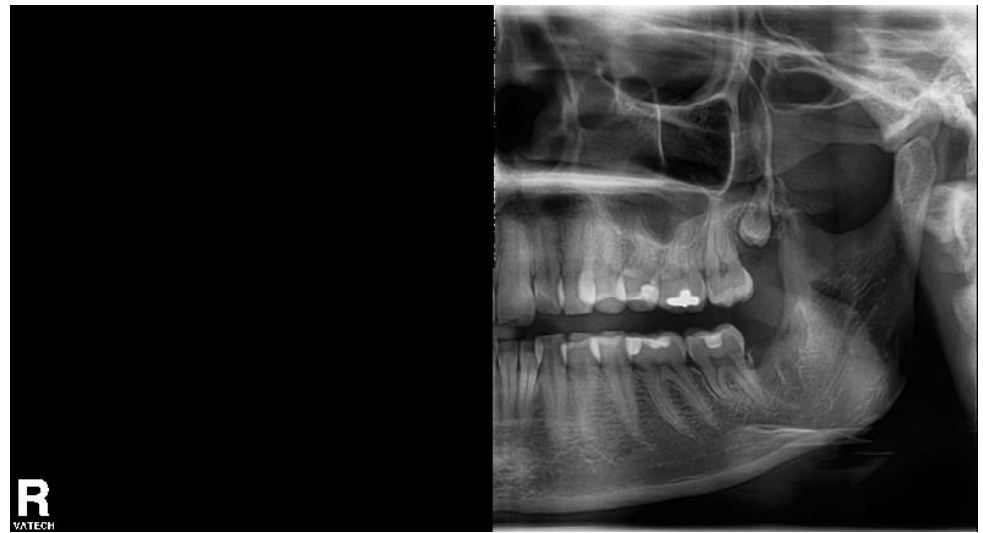
Figure 6. The half orthopantomogram of the left side of the patient 5. An empty socket of the tooth No. 38 is visible.